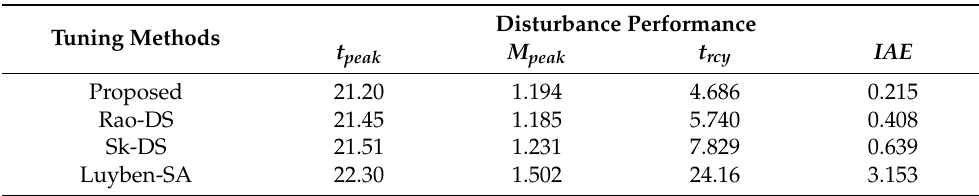
Table 9. Quantitative comparison of responses to disturbance in IFOPTD with +10% parameter mismatch.